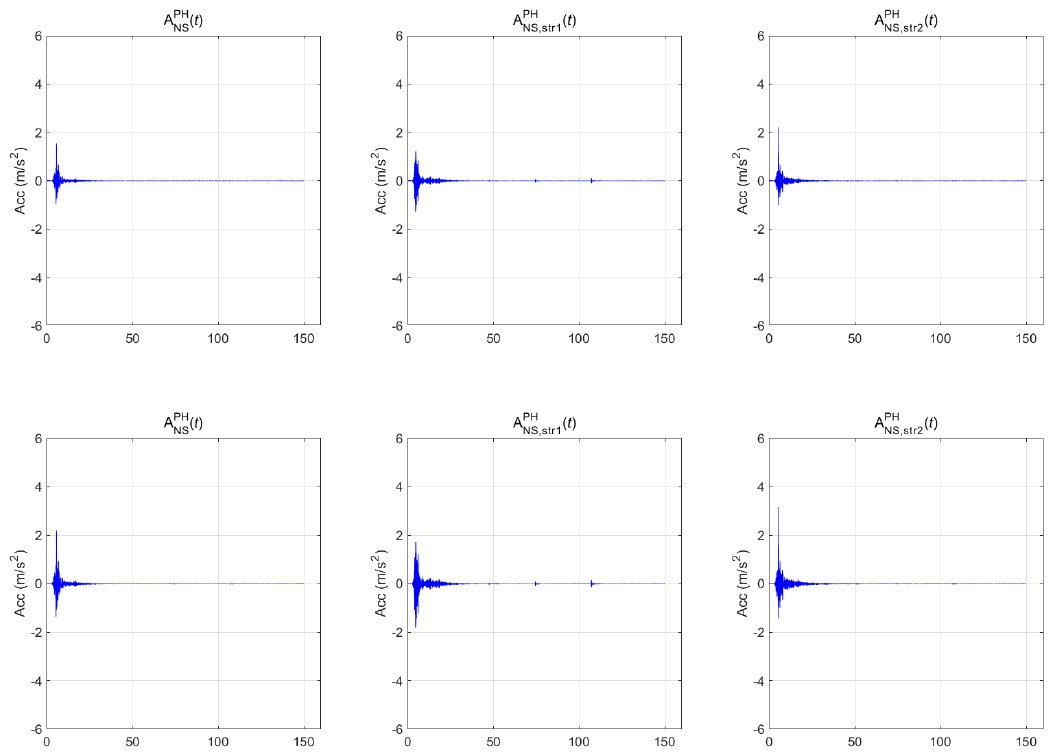
Figure 8. Bridge responses of the Pohang earthquake.